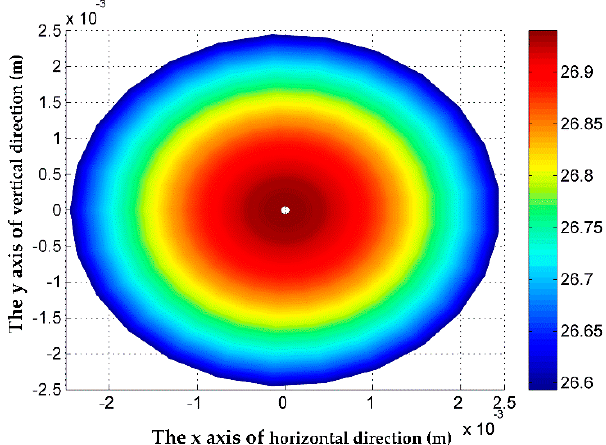
Figure 9. The averaging temperature profile of the laser rod in the segmented side-pumping scheme.